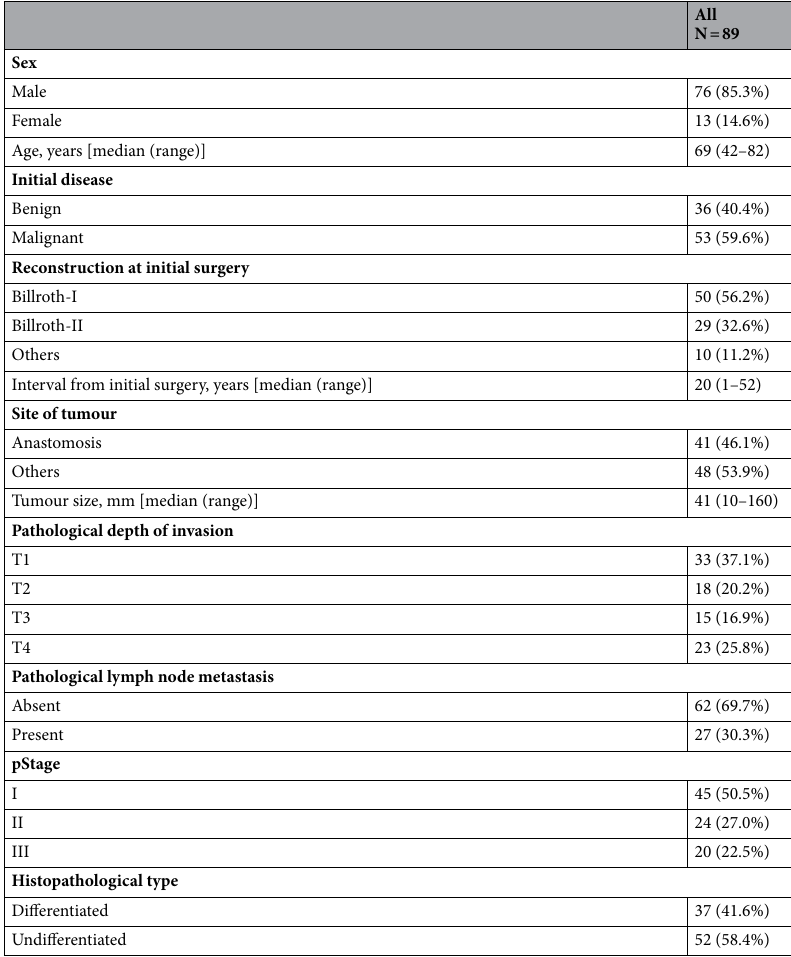
Table 1. Clinicopathological characteristics. The pathological stage as well as T and N numbers were defined using the 8th TNM classification. Histopathological types were classified in accordance with the Japanese classification of gastric